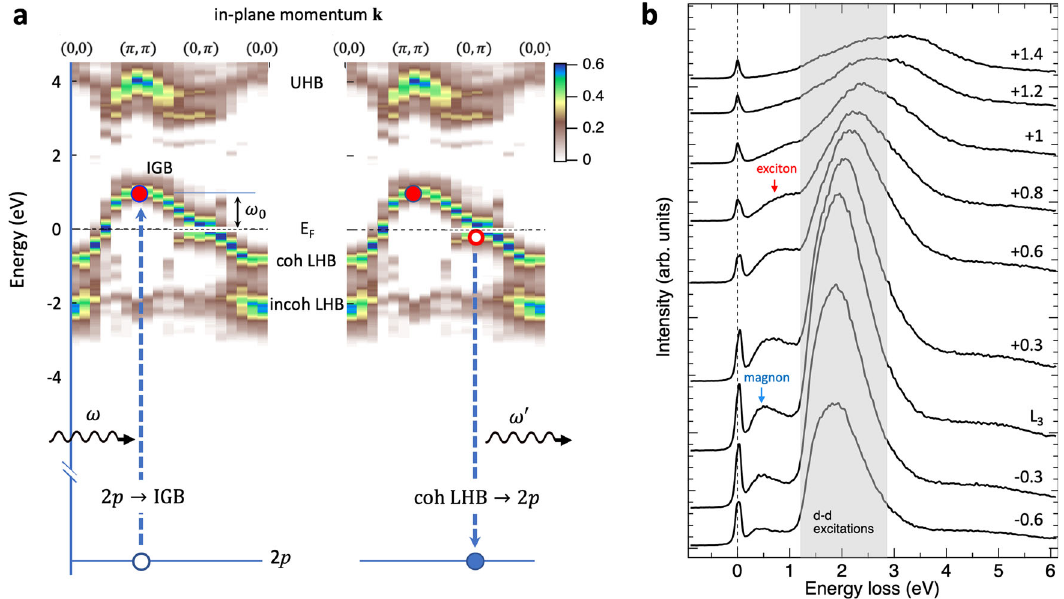
Fig. 1 | Incident energy-dependent Cu L 3 -edge RIXS of hole-doped Bi2212. a IllustrationofexcitonicexcitationinducedinRIXS.Leftandrightpanelsillustrate electronic transitions of resonant absorption and emission, respectively. Color intensity maps show single-particle spectral functions along a symmetric momen- tum line plotted by using data reproduced from Fig. 7a of ref. 28 at hole doping 12.5%. The hopping integral t and the on-site Coulomb interaction U used to simulate the cuprates are t =0.5eV and U =4eV, respectively. The in-plane momenta k are given in units of 1/ a , in which a is the lattice parameter. The coherentpartofthelowerHubbardband(LHB)andtheincoherentpartoftheLHB aredenotedby “ cohLHB ” and “ incohLHB, ” respectively.Theleftpanelshowsthata Cu 2 p electron is excited to the in-gap band (IGB) near ( π , π ) with an energy ω 0